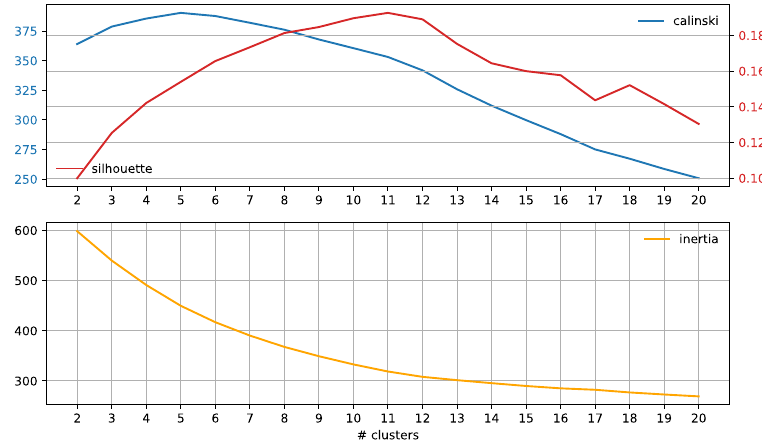
Figure A19. Subreddit migraine.